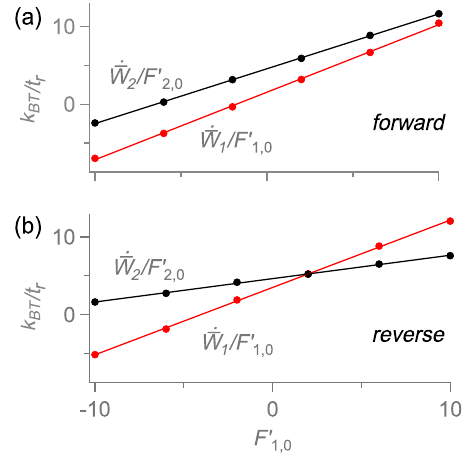
_¯ W =F 0 1 FIG. 1. Experimentally determined , i ¼ 1 , 2, for the i ; 0 forward (a) and time-reversed (b) processes. Typical errors are T=t around (cid:3) 0 . 1 k . Error bars are not shown, as they are smaller B r than the markers indicating the mean values of the data. Solid lines are least-squares linear fits.